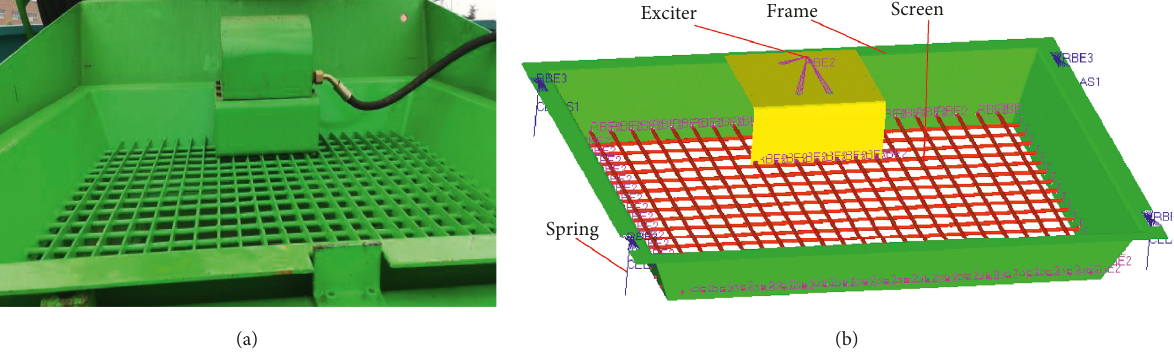
Figure 1: Structure of the vibrating screen: (a) real vibrating screen; (b) finite element model.